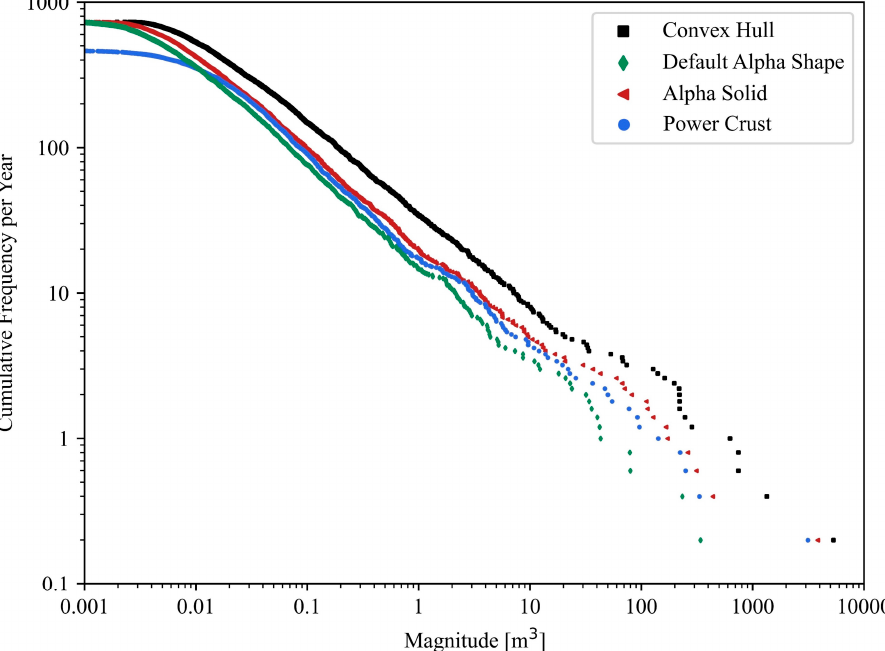
Figure 9. The rank-frequency (cumulative) distributions generated by each of the surface reconstruction methods, with cumulative frequencies normalized by the 5-year monitoring period. The Power Crust dataset does not include the rockfalls for which the reconstruction failed, hence its more significant rollover and unique cumulative frequency. The majority of failed reconstructions were for small-scale point clouds and thus for small volumes.